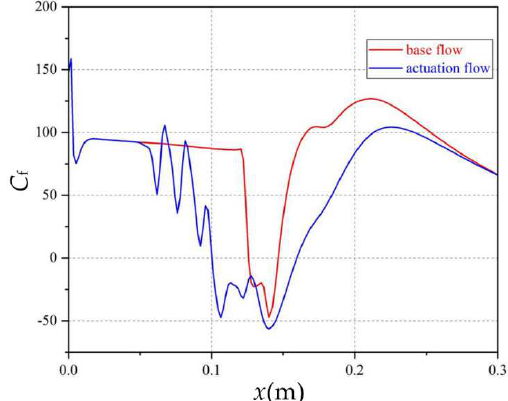
Figure 23. Skin friction coefficient curve at z = 0 cross section.